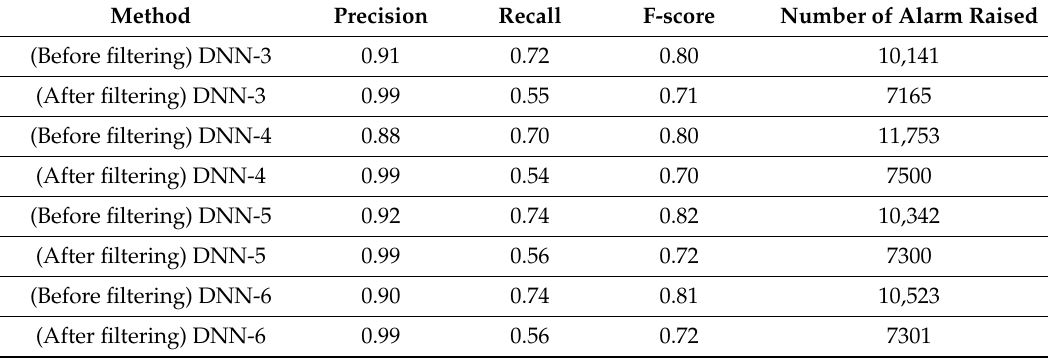
Table 10. Result of two classifications before and after filtering, based on the NSL-KDD test set.